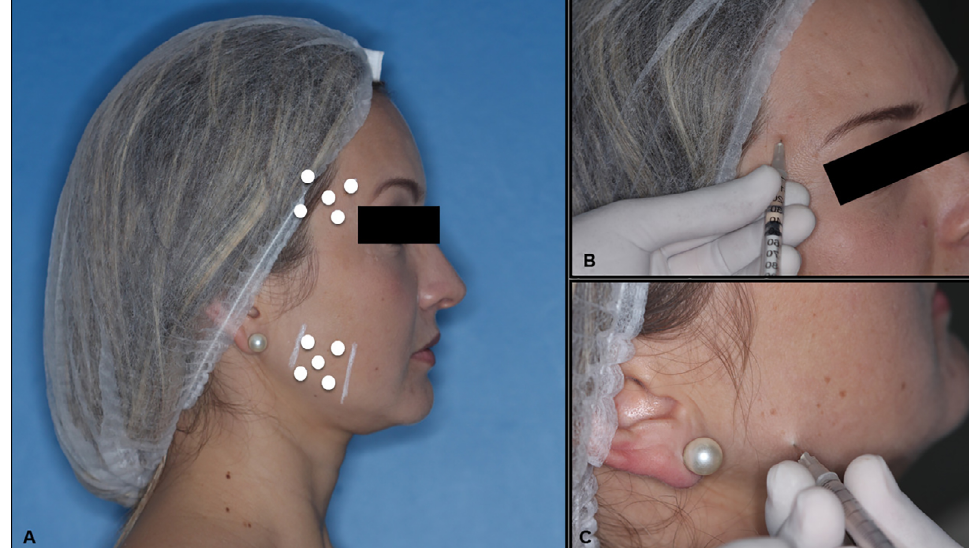
Figure 2- A, marked points for BoNT-A injection. B, temporal muscle injection; C, masseter muscle